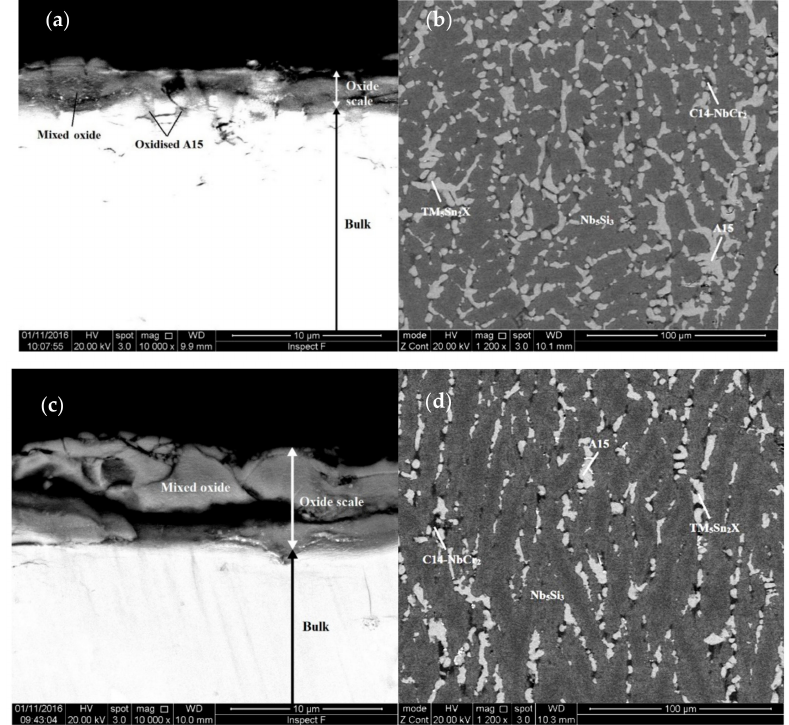
Figure 4. Back-scattered electron (BSE) images of the microstructure of cross sections of the oxidised alloys JZ4 ( a , b ) and JZ5 ( c , d ) at 800 ◦ C ( a , c ) scale, ( b , d ) bulk microstructure. Enhanced contrast in ( a , c ) to show oxide